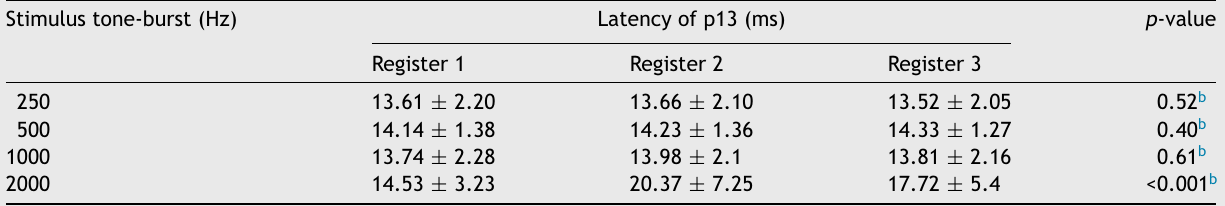
Mean values and standard deviation of the register of latency for wave p13 (test---retest) of vestibular evoked myogenic potential recorded by different tone-burst stimuli, a ( n = 156 for frequencies of 250 and 500 Hz, n = 152 for 1000 Hz, and n = 136 for 2000 Hz).